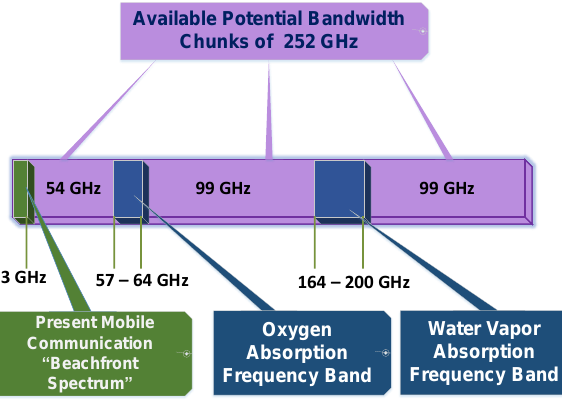
Figure 1. Frequency band of